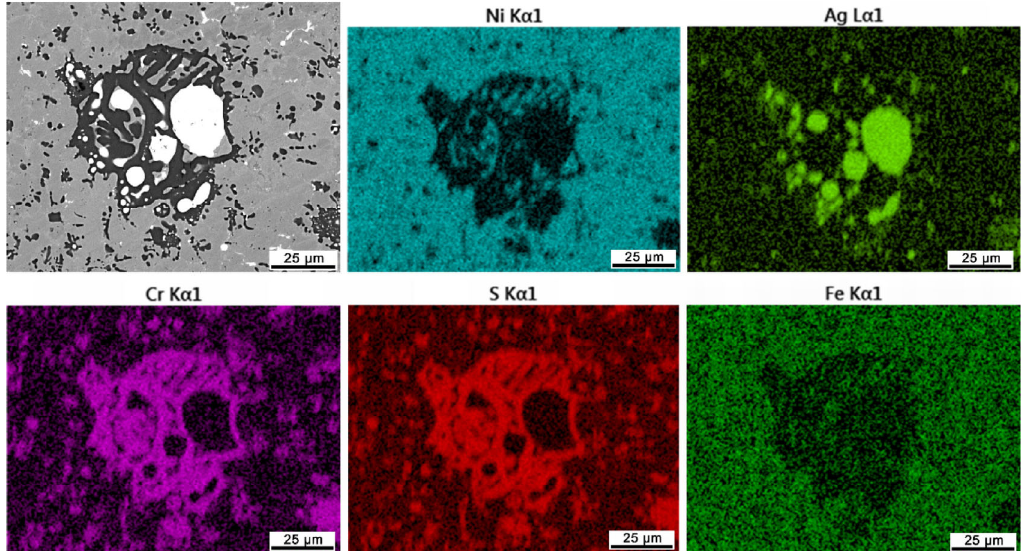
Fig. 25 Illustration of an encapsulated silver inclusions in the as-deposited 5Ag–10 MoS 2 as revealed by SEM and EDS mapping. Reproduced with permission from Ref. [555]. © Elseiver, 2018.